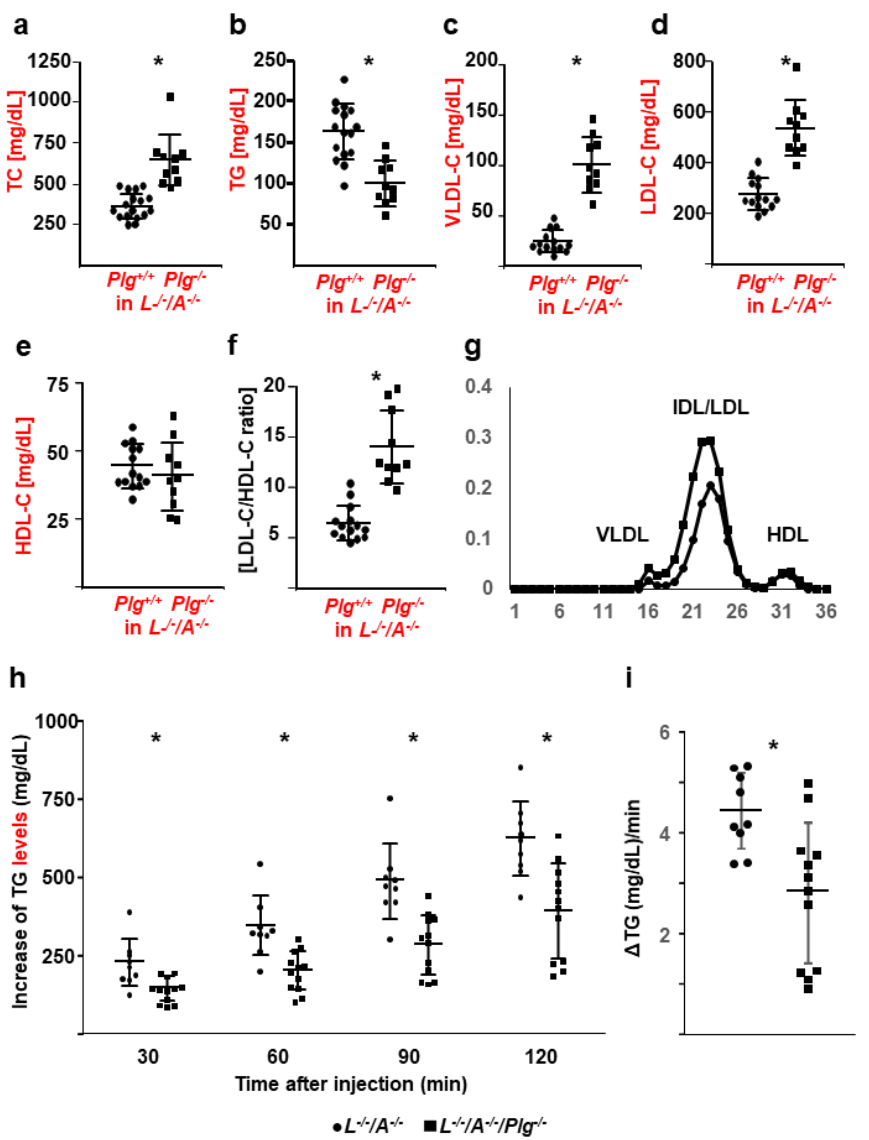
Figure 4. Lipid profiles, CBC, and De novo hepatic synthesis of VLDL. ( a ) TC, ( b ) TG, ( c ) VLDL-C, ( d ) LDL-C, ( e ) HDL-C, and ( f ) LDL-C/HDL-C in L − / − /A − / − (circles) and L − / − /A − / − /Plg − / − (squares) mice ( n = 8–19). ( g ) Typical FPLC profile. ( h ) Increase in plasma TG as de novo VLDL synthesis in L − / − /A − / − (circles) and L − / − /A − / − /Plg − / − (squares) mice ( n = 9–12). ( i ) The VLDL production rate was calculated. * p <